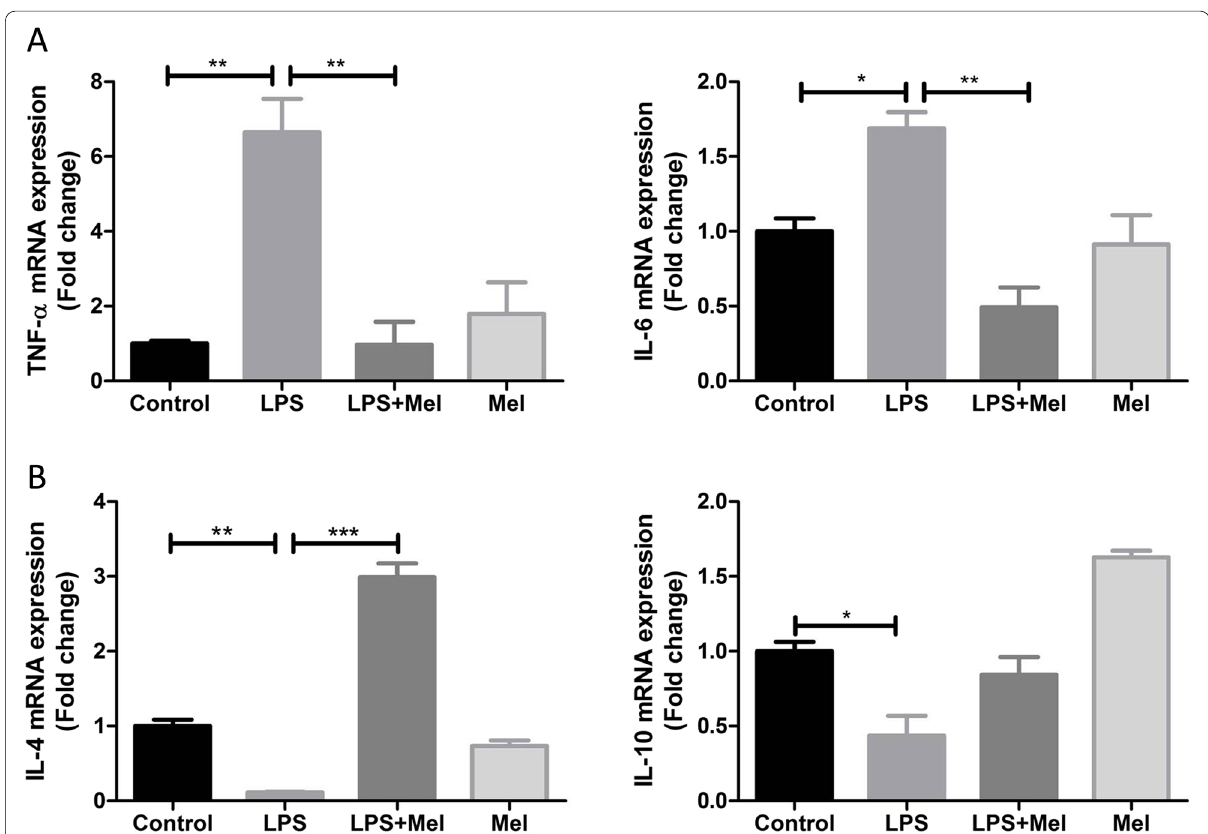
Fig. 3 m-RNA levels of a pro-inflammatory Tnf-α and Il-6 and b anti-inflammatory Il-4 and Il-10 cytokines in adipose derived MSCs treated with lipopolysaccharide (LPS) and/or Melatonin (Mel). Data expressed as mean